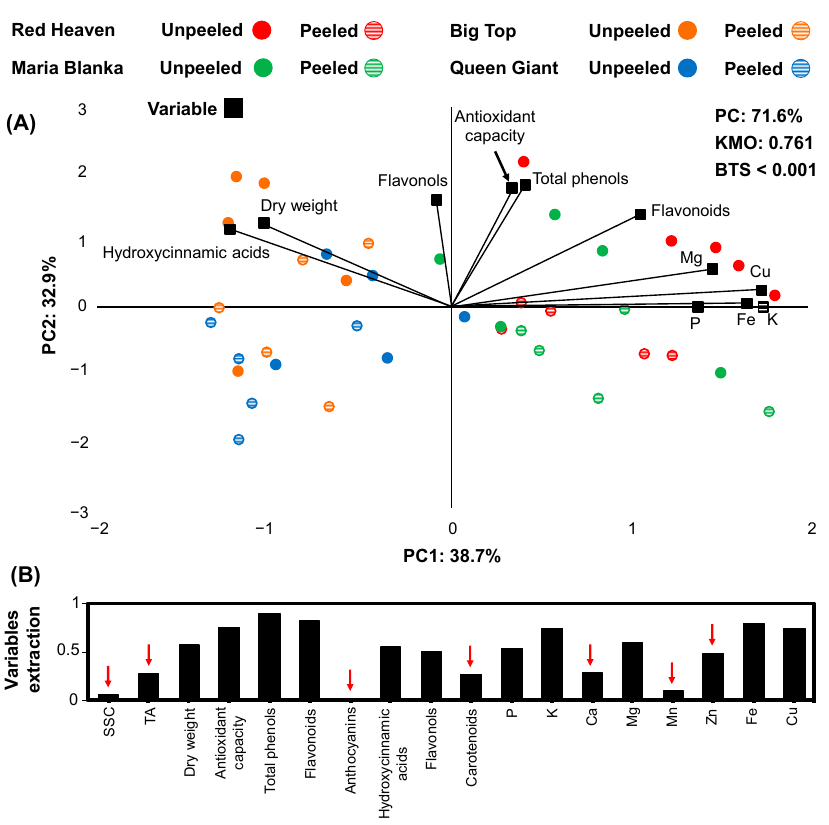
Figure 1. Principal component analysis (PCA) in a biplot ( A ) of physio-biochemical traits and nutrients content (as variables: black) of four peach cultivars (Red Heaven: red, Maria Bianca: green, Big Top: orange, Queen Giant: blue) unpeeled (circle filled with color) compared to peeled (circle filled with horizontal lines) after 2 months of cold storage. Eighteen physio-biochemical and nutrient variables extraction ( B ) based on the representation in the PCA model (red arrows indicate variables with low representation in the PCA model).